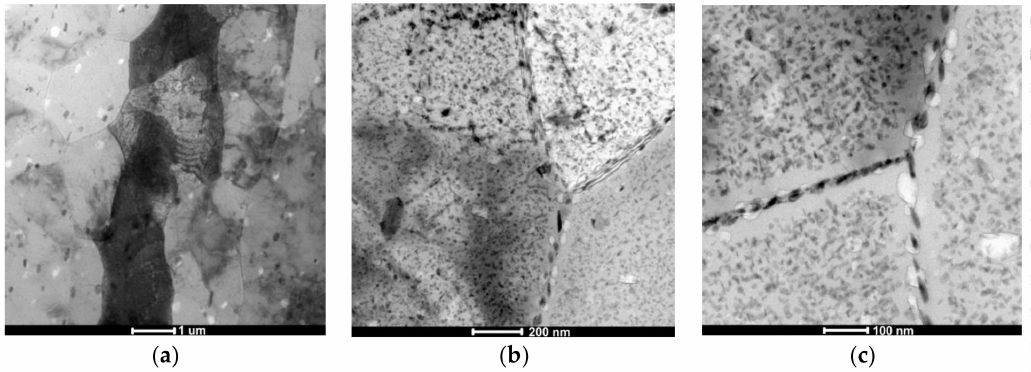
Figure 4. The AlZn6Mg0.8Zr alloy after CHT: ( a ) substructure; ( b ) precipitations inside grains and along grains’ boundaries; ( c ) precipitation-free zones (PFZ) near to grains’ boundaries with continuously distributed precipitates.